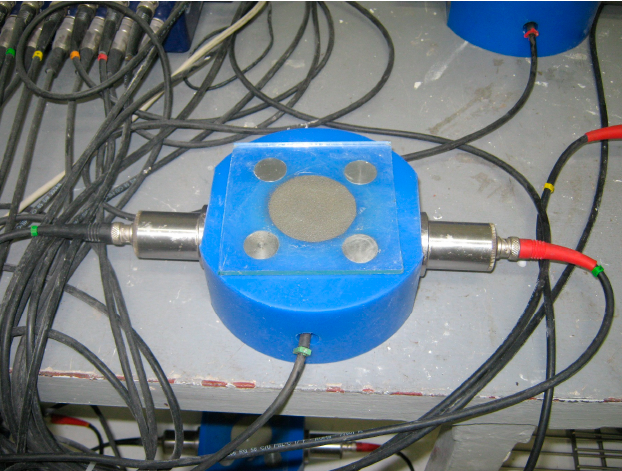
Figure 1. Mortar sample during ultrasonic testing.